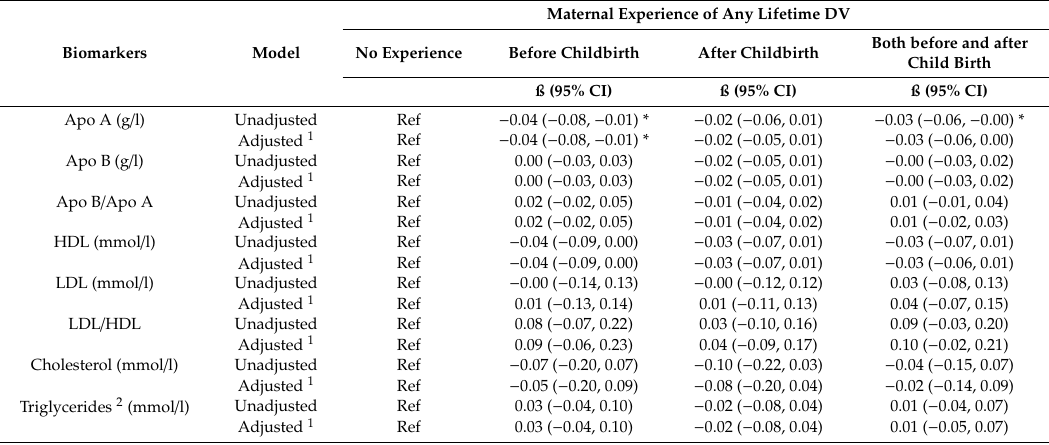
Table 2. Association of children’s level of lipid biomarkers with maternal experience of any lifetime Domestic Violence (DV) before and after